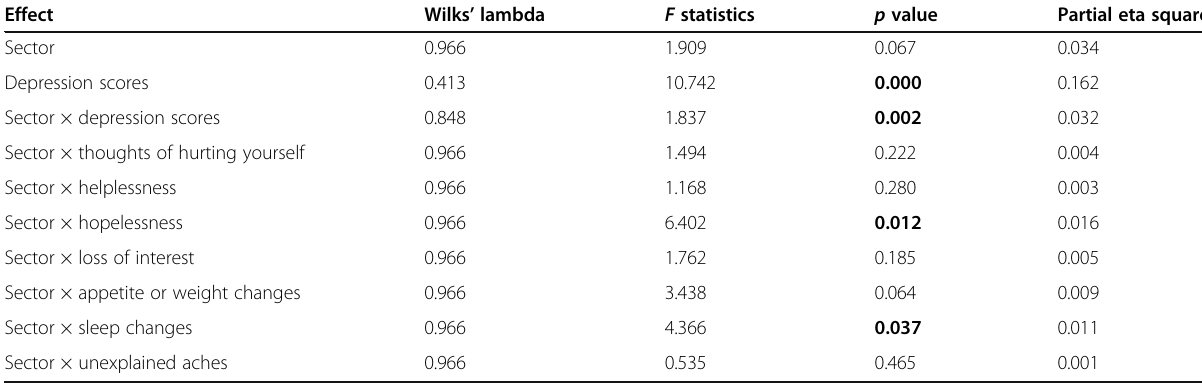
Table 2 Association of depressive symptoms with sectors